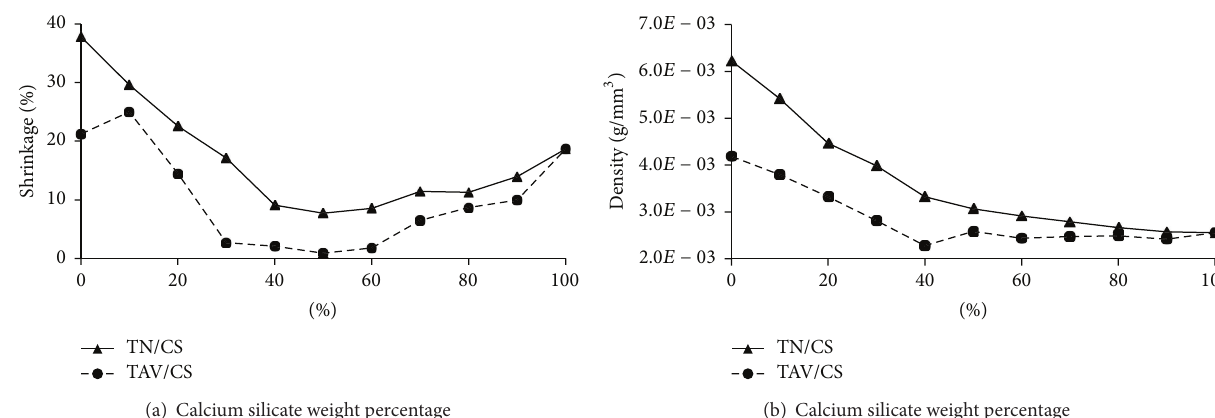
Figure 8: (a) Shrinkage and (b) density of sintered samples of the cermets Ti-55Ni/CaSiO 3 (TN/CS) and Ti-6Al-4V/CaSiO 3 (TAV/CS).